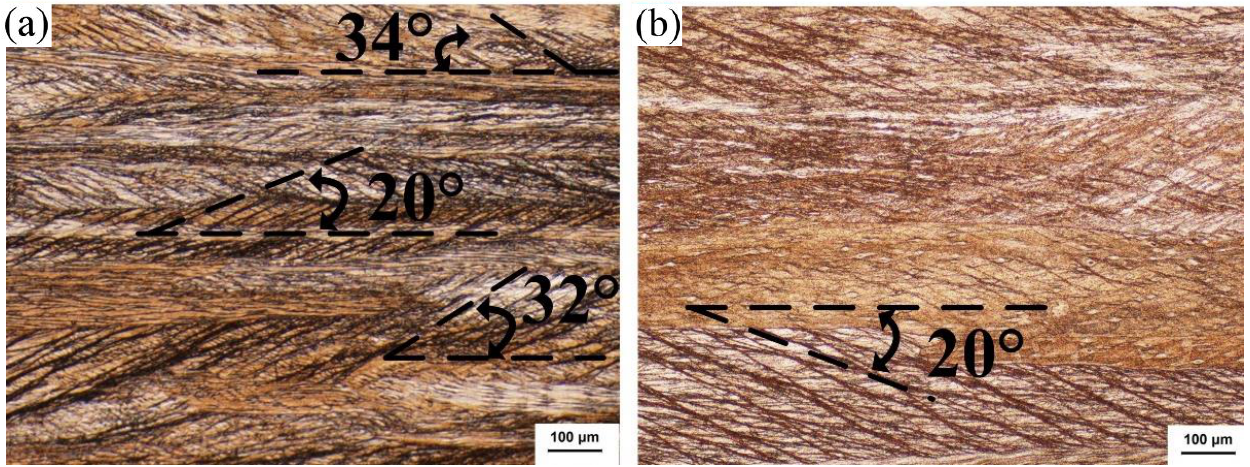
Figure 9. The longitudinal section metallography of cold-rolled strip ( ε = 75%). ( a ) EG strip and ( b ) CG strip.